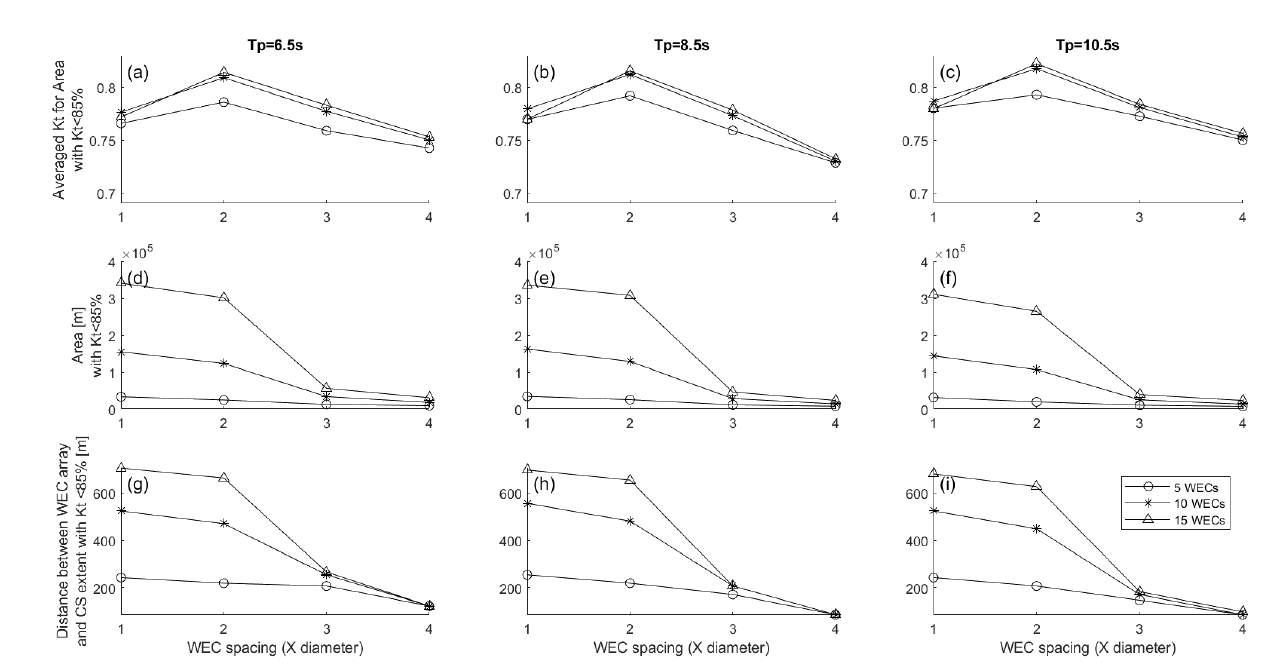
Figure 15. The average transmission coefficient across the region of wake influence ( a – c ). The area that is affected in the wake region ( d – f ). Panels ( a , d , g ), ( b , e , h ), and ( c , f , i ) are differentiated by wave period (6.5 s, 8.5 s, 10.5 s). In each panel, the x-axis shows the width spacing between each WEC, while the lines/markers refer to the size of the WEC array. Panels ( g , h , i ) show the cross–shore (CS) distance of wake influence from the WEC array to the onshore greatest extent of the wake region for different wave periods, WEC spacings and WEC array sizes. H s = 2.5